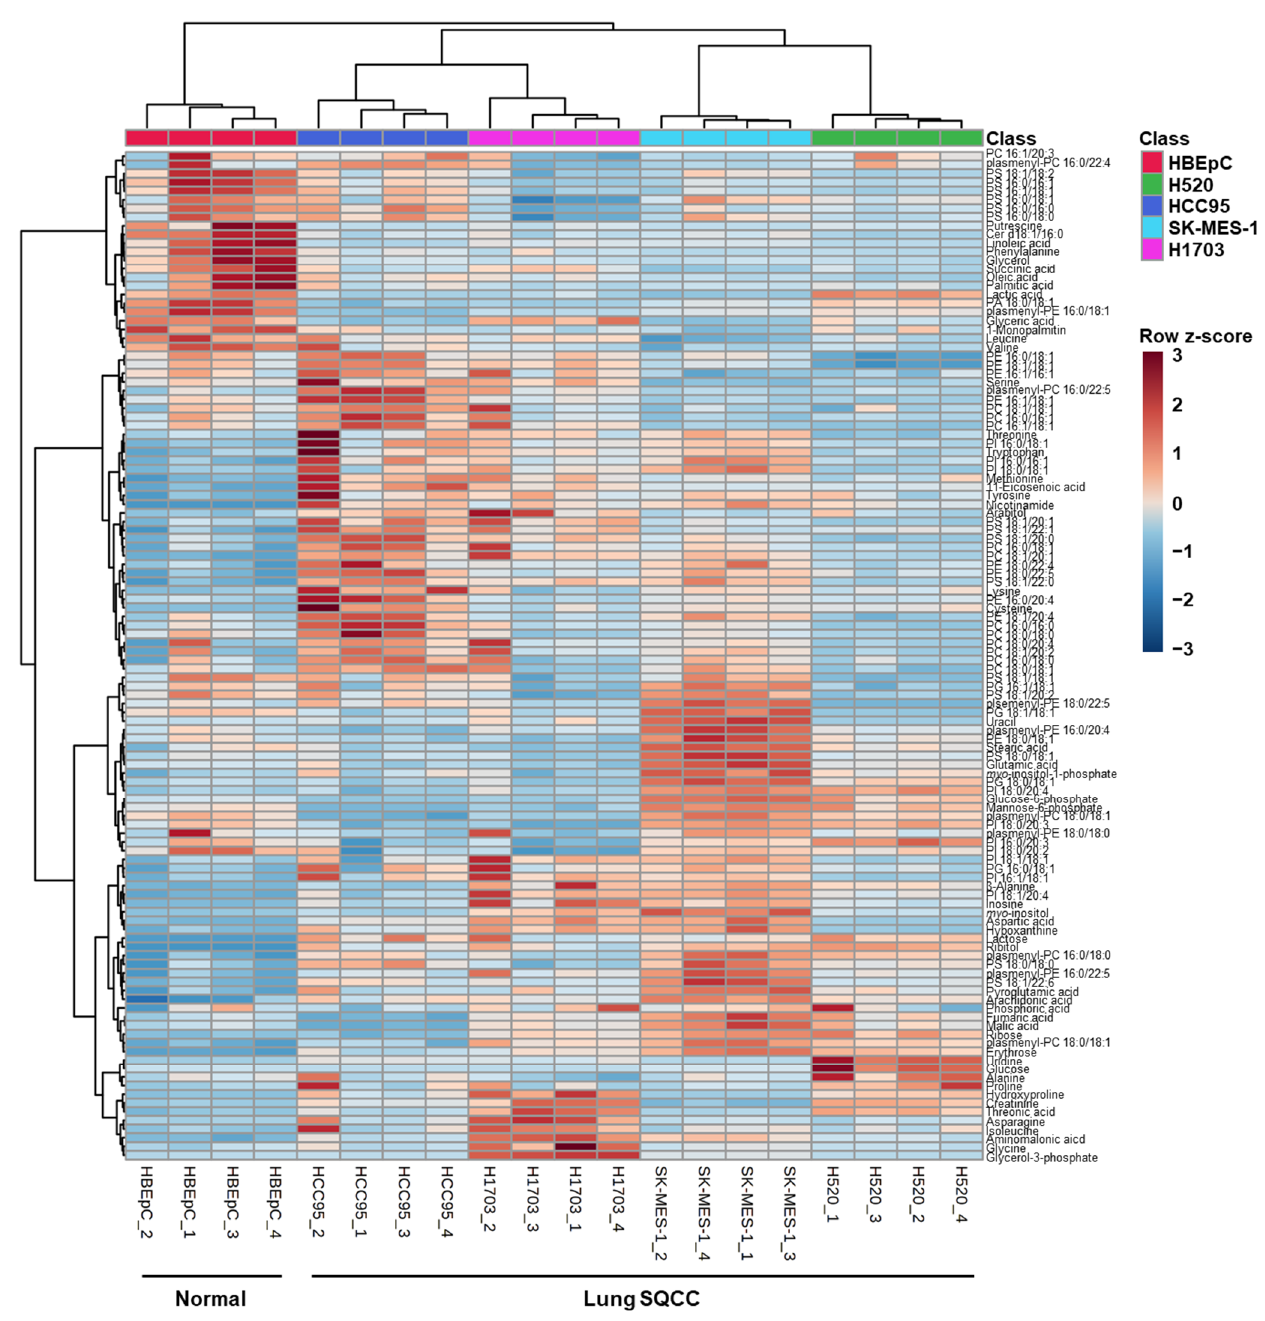
Figure 2. Heatmap demonstrating the relative levels of metabolites and intact lipid species in human bronchial epithelial cells (HBEpC) and four lung squamous cell carcinoma cell lines (H520, HCC95, SK-MES-1, and H1703). ( n = 4, four biological replicates). To indicate the relative levels, the values of biological replicates were represented as mean values of technical replicates in each biological replicate. The row z -score for each compound was used to color code in the heatmap: low concentration compounds were colored as blue, and high concentration compounds were colored as red. PLS-DA was performed to maximize the intergroup separation of each sample. The As shown in Figure 3, there was clear discrimination between each group: normal variable influence on projection (VIP) values derived from the PLS-DA models reflected the cell versus low-metastatic cell lines (Figure 3A), normal cell versus high-metastatic cell influence of each component towards building the predictive model. Metabolites and intact lipid species with VIP values > 1.0 were regarded as compounds that strongly contributed to the ability to predict metastatic potential